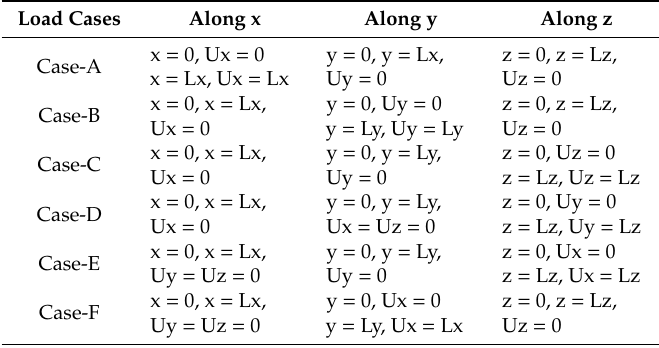
Table 4. Periodic boundary conditions for di ff erent load cases.